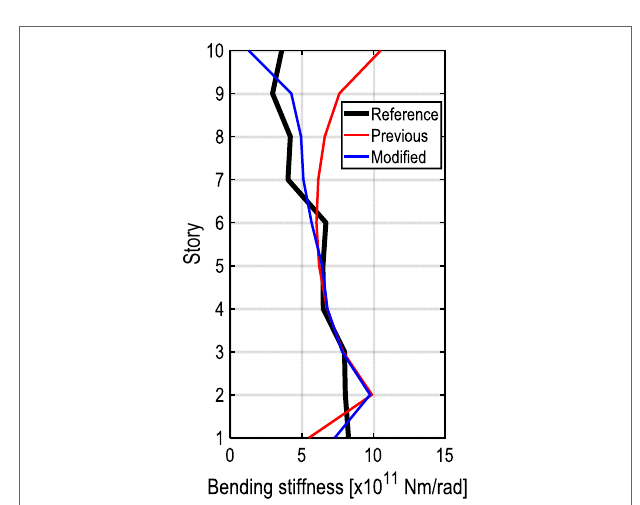
FIGURE 14 | Comparison of identified bending stiffnesses based on empirical formula with modified bending stiffness using probability distribution simulation-based